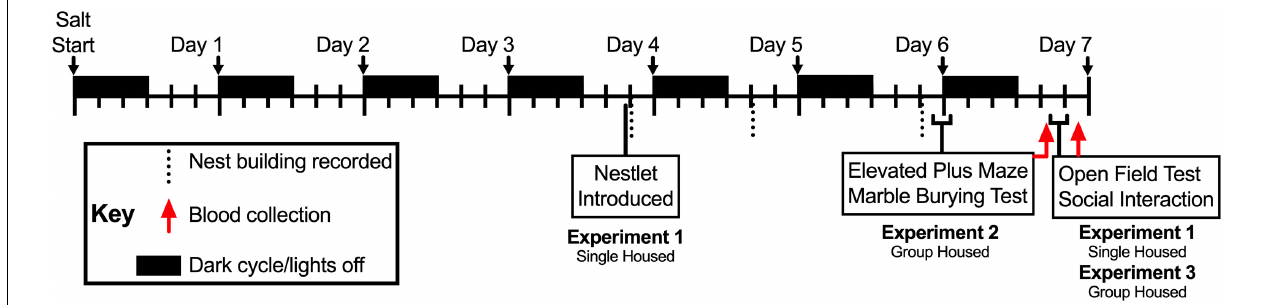
FIGURE 1 | Timeline of Experiments 1, 2, and 3. Drinking manipulations commenced at lights off (1800 h; black rectangles) on Day 0 (i.e., Salt Start), and continued for up to 7 days. Mice in Experiments 2 and 3 were group housed, whereas mice in Experiment 1 were singly housed; the latter to enable individual measurements of nest building. Single nestlets were introduced into the cages of singly housed mice in Experiment 2 at 1315 h during the fourth day, and nest building was scored in the colony room at 1, 20, and 48 h time points thereafter (vertical dotted lines). Mice in Experiments 1 and 3 underwent open field testing (10 min) followed immediately by social interaction testing (10 min) between 1115 and 1415 h on the seventh day, then blood was collected 2 h after completion of social interaction testing (approximately 1340–1640 h; red arrow for Experiments 1 and 3). For Experiment 2, mice were tested in the elevated plus maze (5 min) between 1600 and 1800 h at the end of the sixth day, then immediately tested for marble burying (30 min). On the seventh day, 18 h after completion of the marble burying test, blood was collected from mice in Experiment 2 (approximately 1040–1310 h; red arrow for Experiment